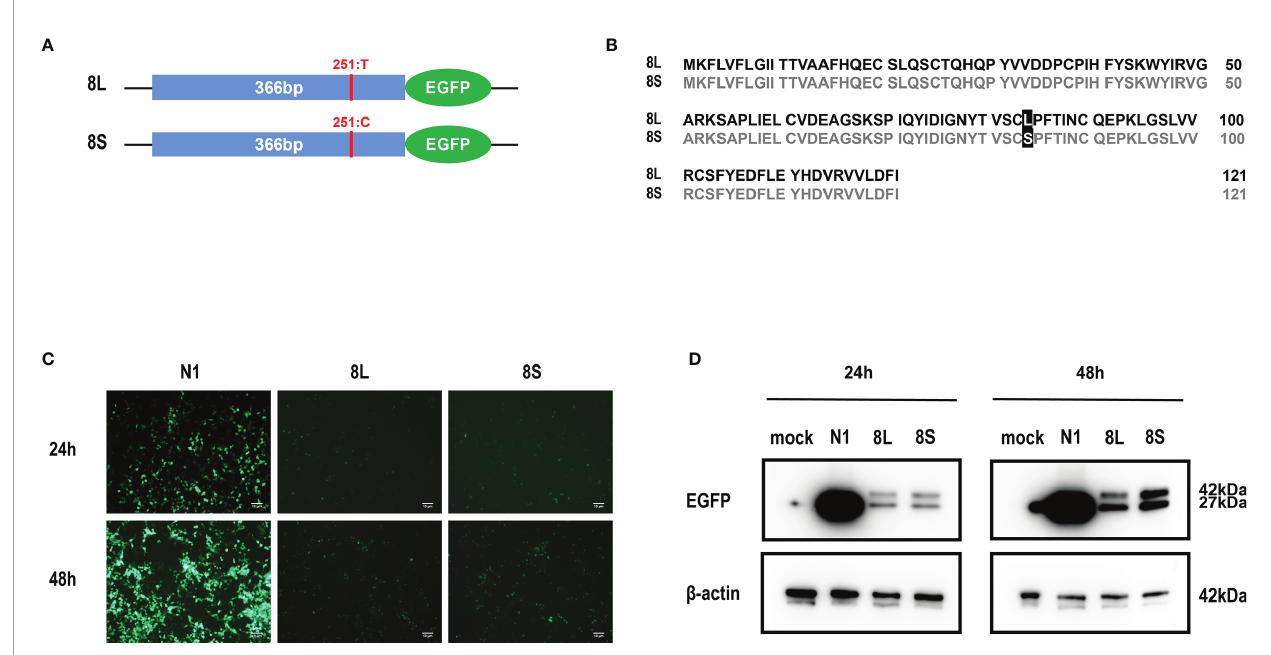
FIGURE 1 | Expression of pEGFP-ORF8L and pEGFP-ORF8S in HEK293T cells. (A) Schematic diagram of ORF8L and ORF8S expression vectors. The only mutation of nucleotide 251 was T in ORF8L and C in ORF8S. (B) Alignment of amino acid sequence in ORF8L and ORF8S. Leucine in ORF8L was substituted by serine in ORF8S at amino acid 84. (C) Images of fl uorescence-labeled ORF8L and ORF8S proteins in cells were obtained by fl uorescence microscopy. Scale bar, 10 m m. (D) Expression of ORF8L and ORF8S proteins was examined by Western blot assay. The ORF8L-EGFP and ORF8S-EGFP proteins have a putative molecular weight of nearly 42 kDa, and EGFP protein alone has a molecular weight of 27 kDa. pEGFP-N1, N1; pEGFP-ORF8L, 8L; pEGFP-ORF8S,